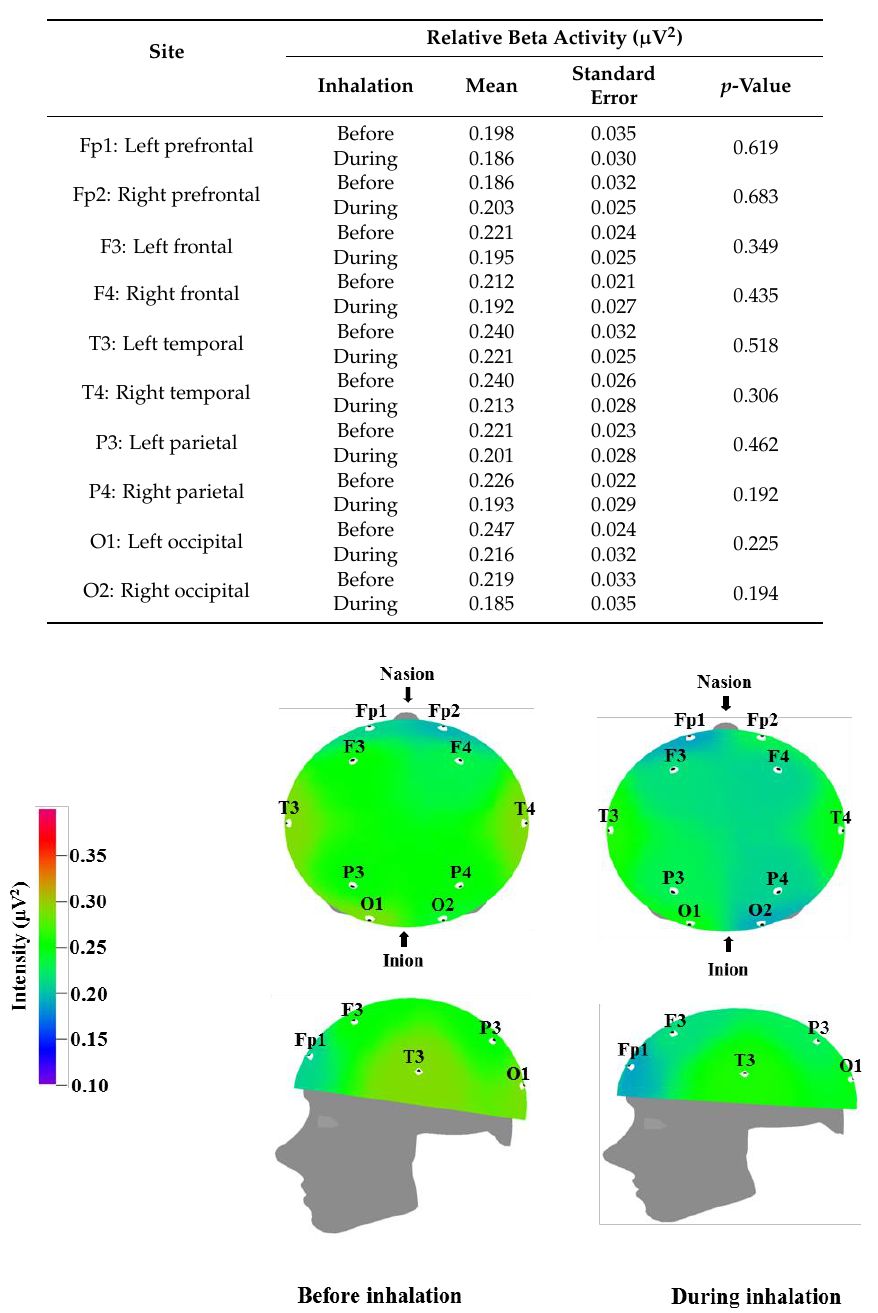
Table 5. Effect of inhalation of volatile organic chemicals (VOCs) from Chrysanthemum indicum Linné on relative beta wave.